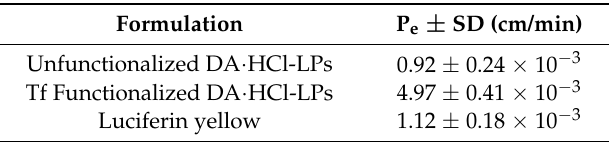
Table 3. hCMEC/D3 permeability values (P e ) of DA ∙ HCl-LPs, functionalized DA ∙ HCl-LPs and luciferin yellow ± standard deviation (SD).